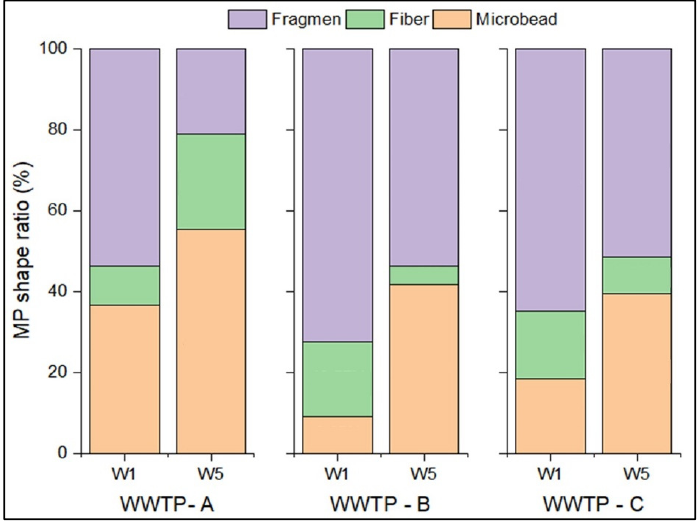
Figure 3. Result of microscope observation for microplastic particles.